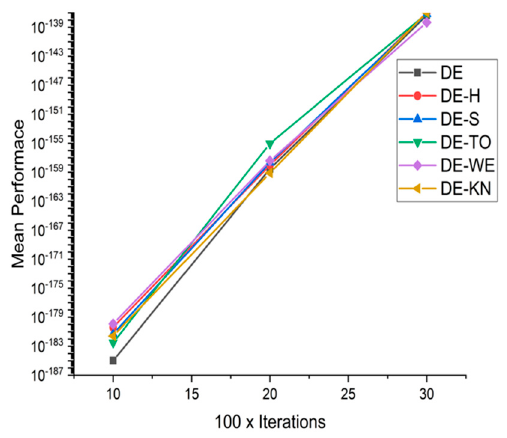
Figure 36. Convergence curve on fn14.